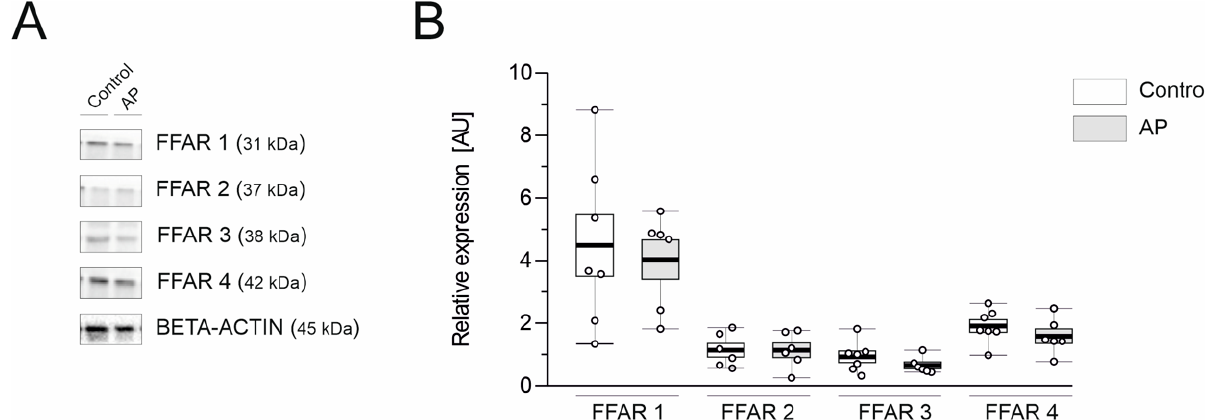
Figure 4. Representative western blots demonstrating the expression of all analyzed proteins – free fatty acid receptors (FFARs) ( A ) and changes in the protein concentration of FFARs ( B ) in the pancreas of healthy mice and mice with evoked acute pancreatitis. Beta-actin was used as a loading control for Western Blot to normalize the levels of protein. Data presented as raw data (circles) and means (horizontal bolded lines) with SEM (boxes) ( B ); n = 6–7.